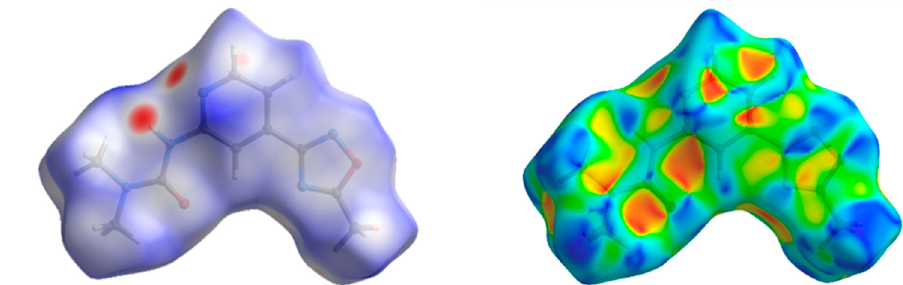
Figure 3. The Hirshfeld surfaces for 1a , mapped with d norm over the range –0,20 (red) to 1,00 (blue) ( a ) moieties; shape index (S), mapped from –1,0 (concave hollows; red) → 0,0 (minimal saddle; green) → +1,0 (convex bumps; blue) ( b ).